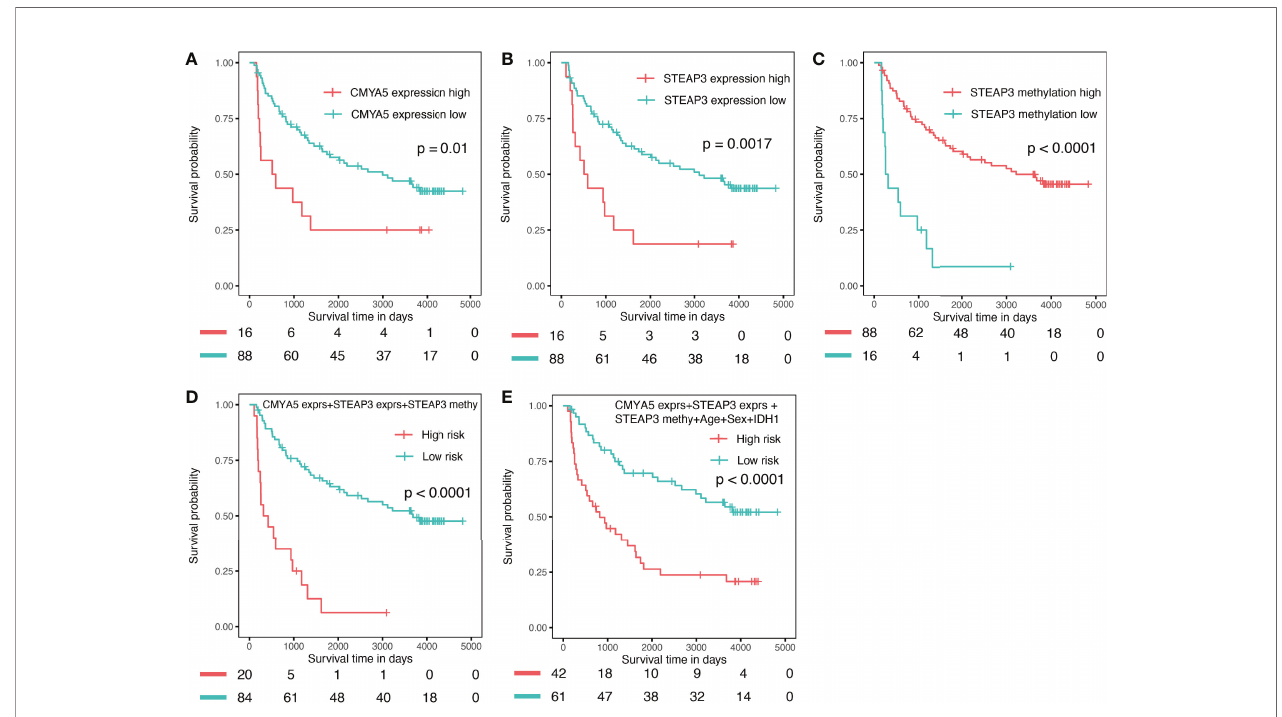
FIGURE 9 | Validation in the external CGGA validation dataset. (A) K – M OS curves of CMYA5 expression (B, C) of STEAP3 expression and methylation. (D) combination of CMYA5 expression, STEAP3 expression and methylation. (E) combination of CMYA5 expression, STEAP3 expression and methylation with age, sex, and IDH1